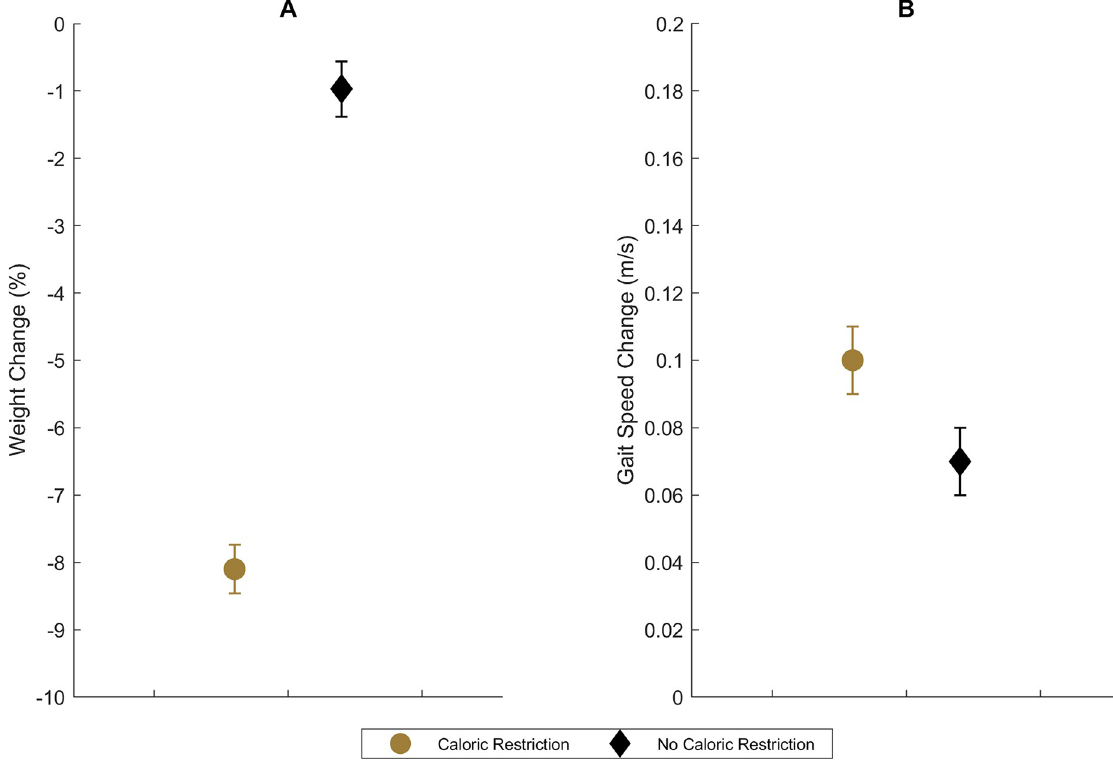
Fig 1. Crude six-month mean (95% Bayesian Credible Interval) change in percent weight (A) and fast-paced gait speed (B) by caloric restriction assignment group. relative changes: CR: -8.1 (5.9) % vs. NoCR: -1.0 (3.7) %; p < 0.01], with significant differences BMI change as well [CR: -2.8 (2.1) kg/m 2 vs. NoCR -0.4 (1.3) kg/m 2 ; p < 0.01]. In unadjusted